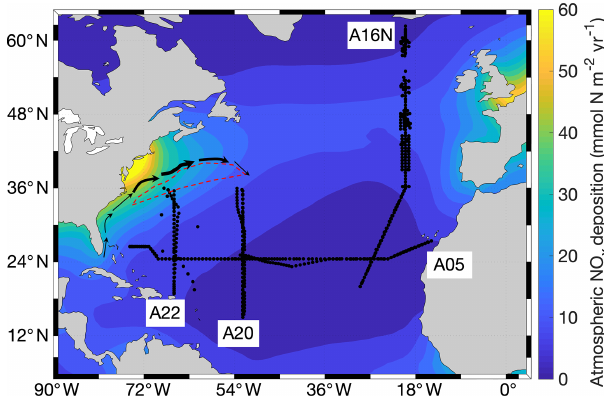
Figure 1. Nutrient sampling locations (black dots) in the North At- lantic Ocean (NAtl). All datasets from the meridional (A22, A20, and A16N) and zonal (A05) cruises were collected in the GLO- DAPv2 product and CLIVAR database (see text). The red dashed line indicates the region of subtropical mode water (STMW) for- mation, and the solid arrows indicate streamlines of high transport in the western NAtl (i.e., the Gulf Stream, modified from Palter et al., 2005). The color scale indicates the model-derived atmospheric NO x deposition into the NAtl for 2000 (Dentener et al.,